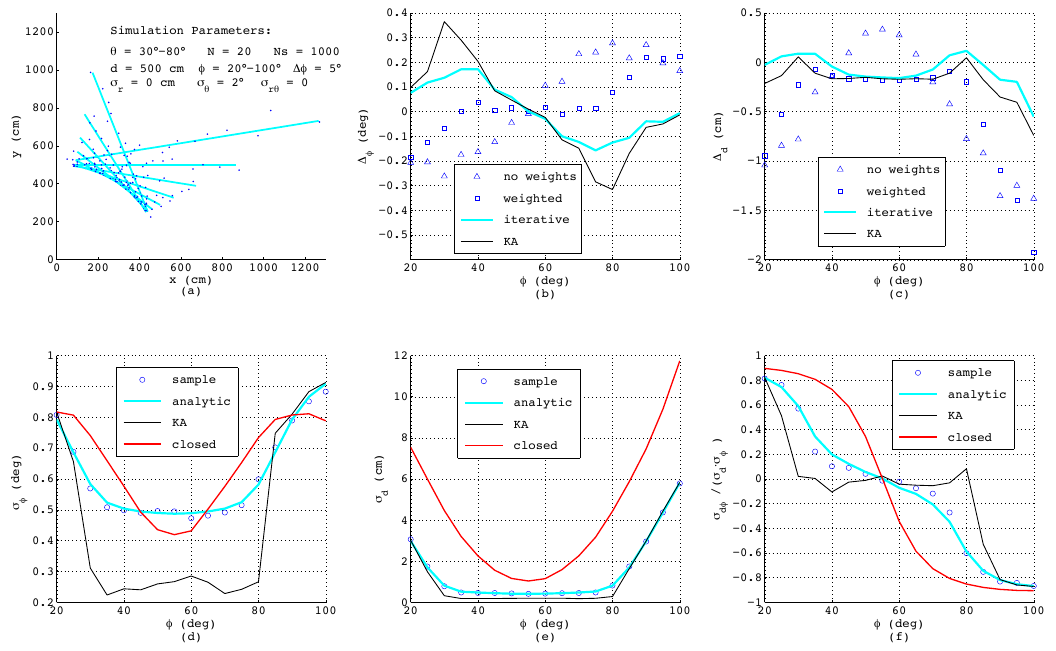
Figure 9. Results from simulated range-bearing scans superimposing high noise only in the θ -direction.